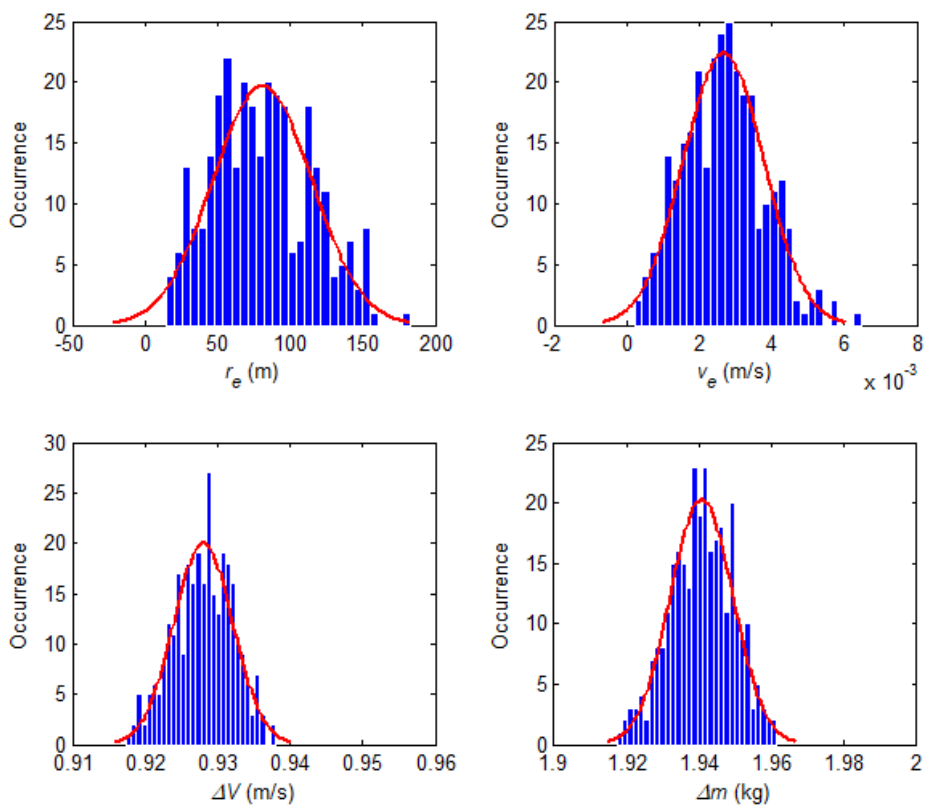
Figure 10. Occurrence of the Monte Carlo simulation (Error setting II, ε = 2 TOF 40 h ).